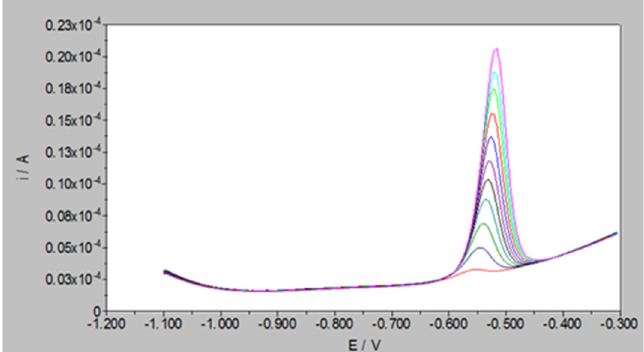
Figure 1 . The current versus potential graph of Square Wave Anodic Stripping Voltammetry (SWASV) with standard addition of Pb 2+ .